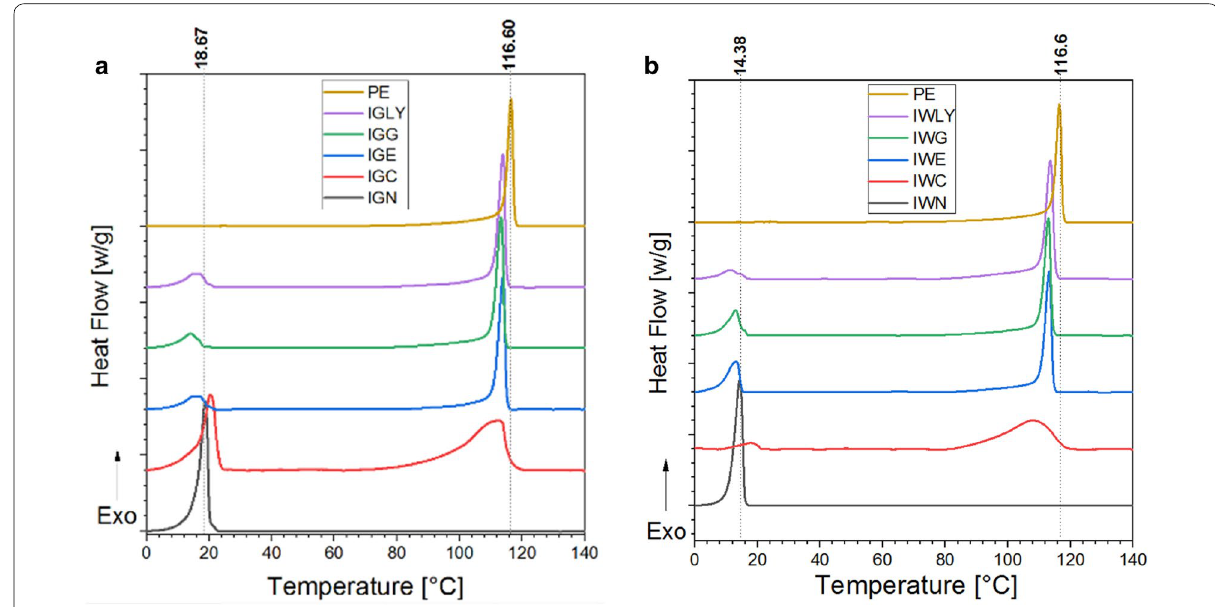
Fig. 4 DSC thermograms of Irvingia‑based adhesives (crystallization profile)